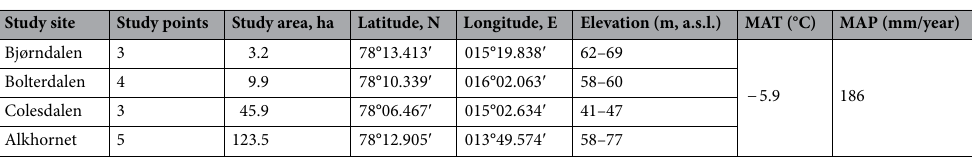
Table 1. Study site